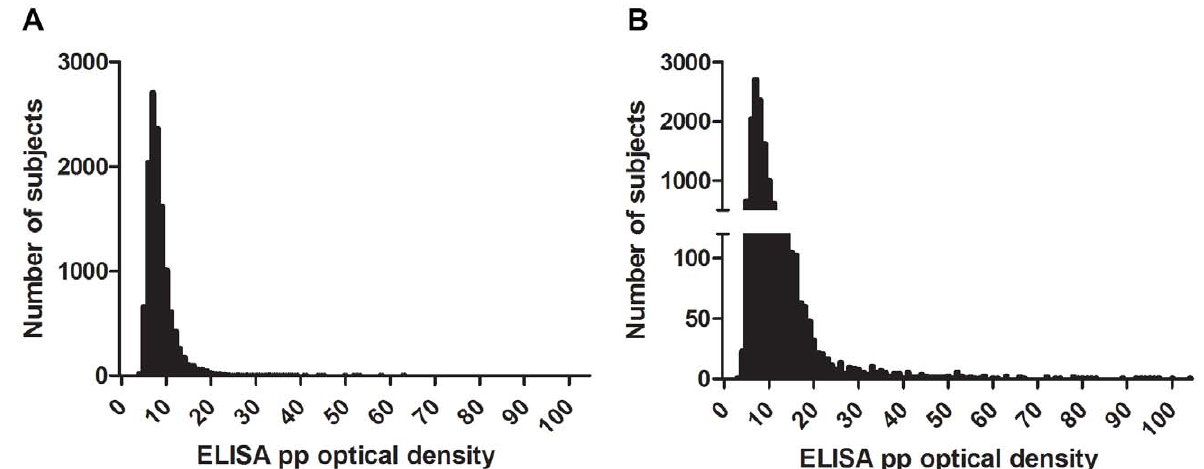
Figure 2. rK39 optical densities at baseline. Serologic titers are graphed for the 12,634 subjects without prior or current VL, measured by rK39 ELISA. The data are expressed as percentage of positive (pp), calculated as the (subject OD/positive control OD) 6 100 control for each subject. The left and the right figure show the same data on different scales, so that range of OD titers below 45 can be appreciated.